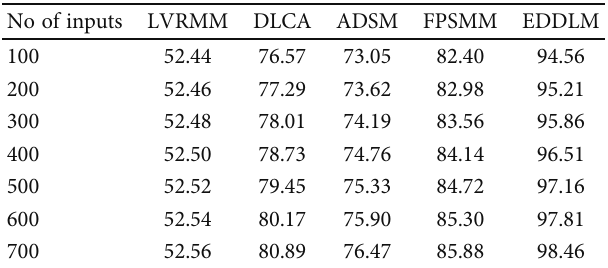
Table 6: Solar energy management.